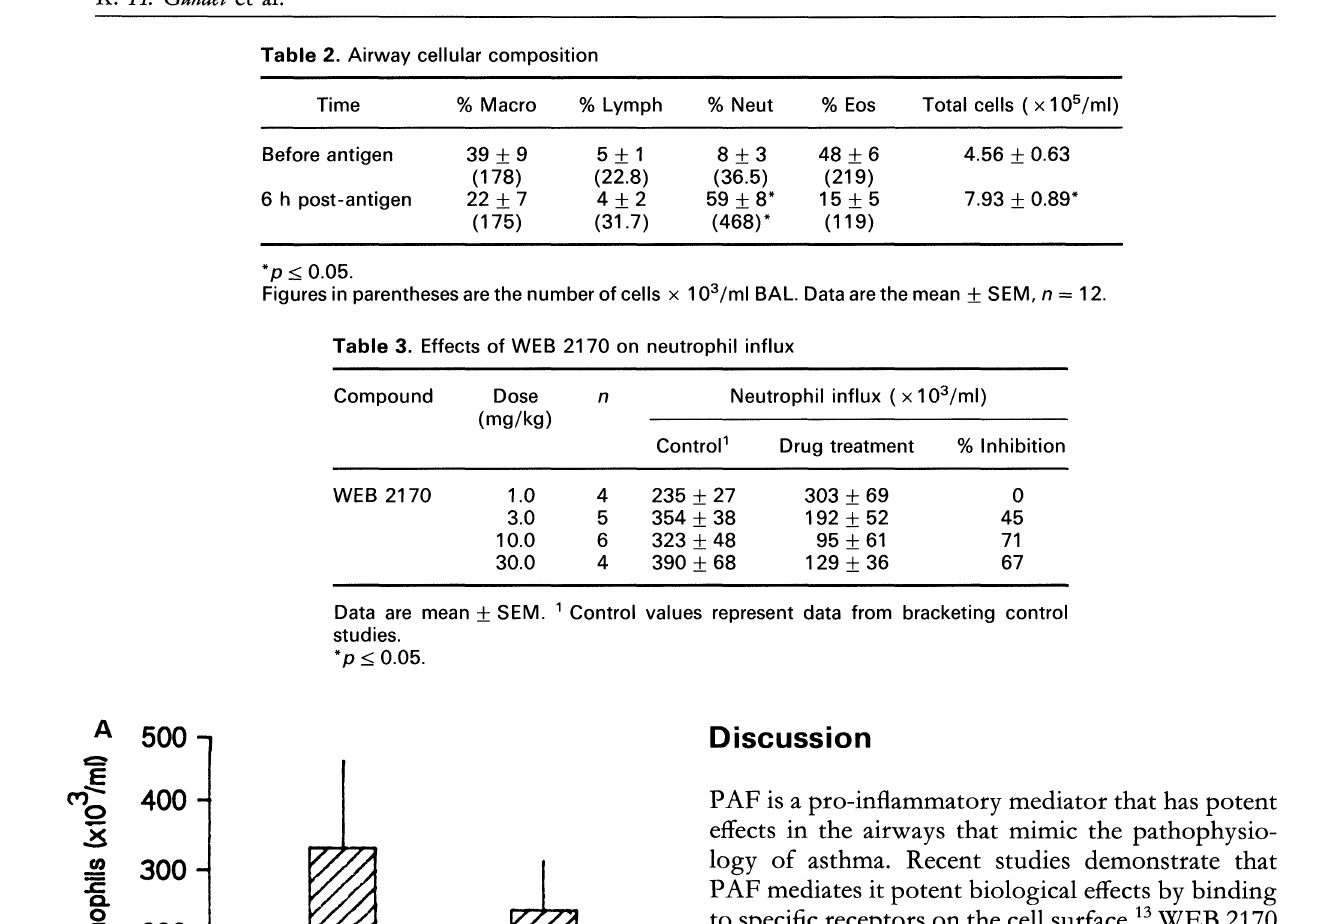
Table 2. Airway cellular composition